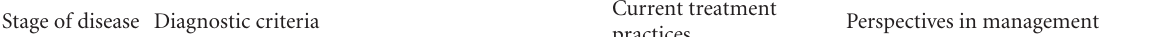
Table 2: Summary of diagnostic criteria and treatment currently in use as well as its perspectives in management. Stage of disease Diagnostic